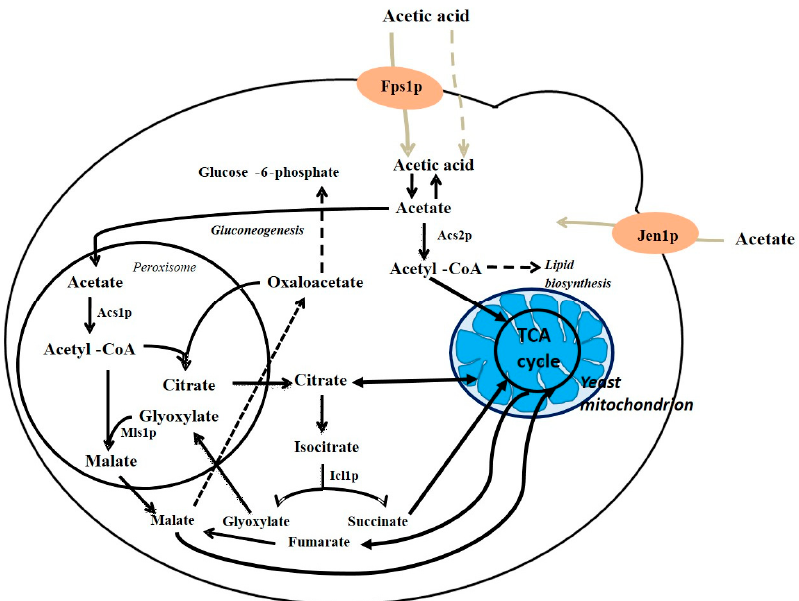
Figure 5. Cell compartmentation of acetate metabolism in yeast: Black arrows show metabolic pathways and light brown arrows represent acetic acid or acetate transport systems; Fps1p, aquaglyceroporin that mediates the transport of the undissociated form of acetic acid across yeast membranes (solid line); Acetic acid can also enter de cell by simple diffusion (dotted line); Jen1p, S. cerevisiae lactate transporter that is also able to transport acetate. Adapted from Vilela-Moura